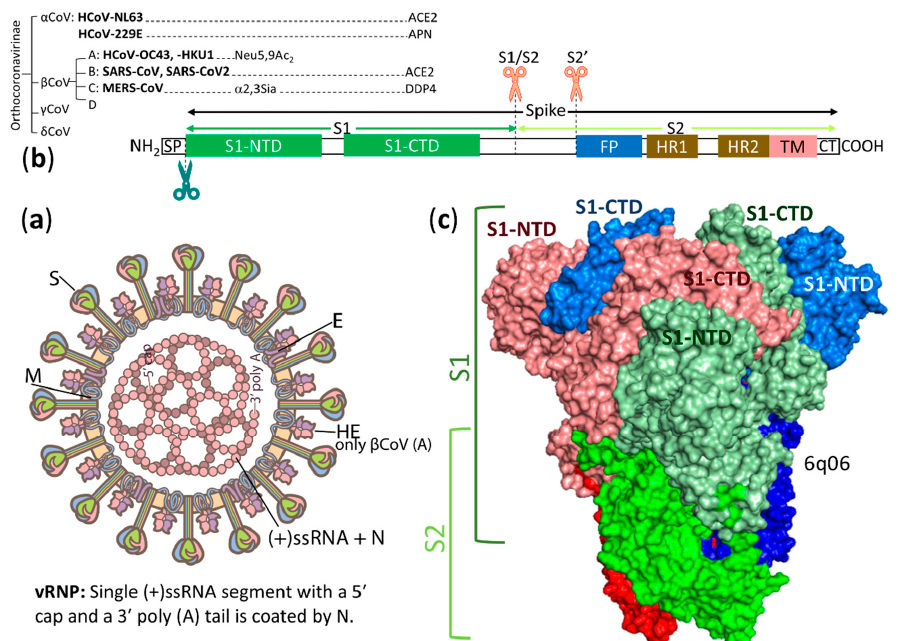
Figure 2. Schematic structures of a CoV and its spike protein. ( a ) The CoV is a pleomorphic spherical enveloped particle. It contains a linear positive-sense, single-stranded RNA with a 5 (cid:48) cap and a 3 (cid:48) poly(A) tail that are enclosed by nucleocapsid (N) proteins. The lipid bilayer envelope carries 3–4 structural proteins. (i) Membrane (M) proteins are the most abundant small triple-spanning transmembrane proteins that define the virion morphology and are major coordinators of virion assembly [140]. (ii) Envelope (E) proteins are minor channel-spanning transmembrane proteins that work together with the M proteins for virion assembly, budding and release [141]. (iii) Spike (S) proteins are homotrimeric type I transmembrane glycoproteins [142] protruding from the virion envelope (20 nm in length) that resemble a crown (Latin: corona) under an electron microscope. S proteins are major antigenic surface proteins and are critical for virion entry into a specific host cell by binding to a specific receptor(s) on the host cell surface and mediating membrane fusion [143]. (iv) The members of β CoV lineage A have additional short hemagglutinin esterase (HE) spikes (5 nm in length), which are homodimeric type I transmembrane glycoproteins. CoV HE has the potential to evolve its O -Ac-Sia receptor-binding specificity and activity, along with its companion S proteins, in balance with its receptor-destroying sialate O -acetylesterase activity for e ffi cient virus infection and spread [86,94,144]. ( b ) Diagram of the unfolded S polypeptide composed of an N-terminal signal peptide (SP), an S1 subunit and an S2 subunit. The N-terminal signal peptide is a short type 1 signal hydrophobic peptide probably cleaved during cotranslational transport across the endoplasmic reticulum [145]. The S1 subunit carries 2 important domains, an S1 N-terminal domain (S1-NTD or S1 A ) and an S1 C-terminal domain (S1-CTD or S1 B ), one of which or both of which function as a host receptor-binding domain depending on the virus. Host receptors of CoVs a ff ecting humans are shown above the bound S1 domain. The S1 / S2 boundary with multiple basic aa residues may be potentially cleaved by furin during virus exit, while the monobasic cleavage site may be cleaved by a target cell protease, such as TMPRSS2 (trypsin-like protease) and cathepsin L [146], generating the S1 and S2 subunits with a noncovalently link [147]. The S2 subunit carries 5 regions. (i) The S2 (cid:48) cleavage site may contain monobasic or two basic residues that must be cleaved by a host protease [146]. Both S1 / S2 and S2 (cid:48) cleavage sites must be cleaved to enable its S protein to mediate membrane fusion. (ii) A fusion peptide (FP) that mediates fusion of the virion envelope with the cellular plasma membrane or with the cellular endosomal membrane, followed by (iii) 2 heptad repeats (HR1 and HR2) promoting fusion [147], (iv) a transmembrane (TM) domain anchoring to the envelope and (v) a cytoplasmic tail (CT). ( c ) Side view of a surface diagram of a trimeric CoV S protein (pdb: 6q06 [148]). Each monomer of the S trimer is colored as follows: salmon, S1 and red, S2; marine blue, S1 and blue, S2; pale green, S1 and green, S2. S1-NTD and S1-CTD are on each S1 head above each S2